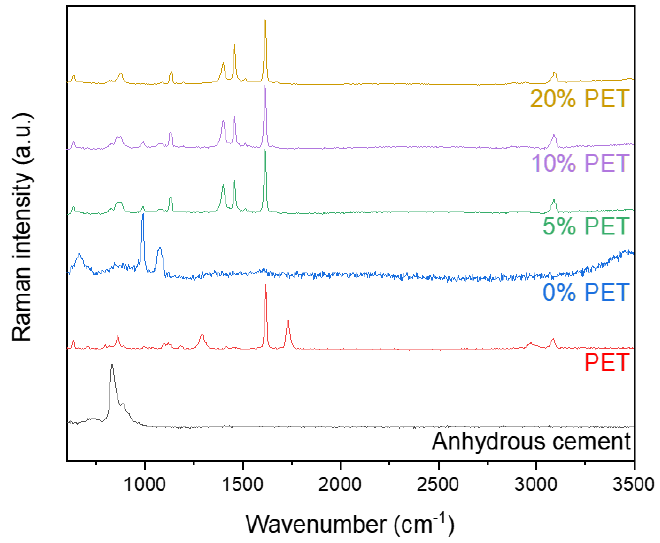
Figure 10. Raman spectra of cement paste samples incorporating PET powder.